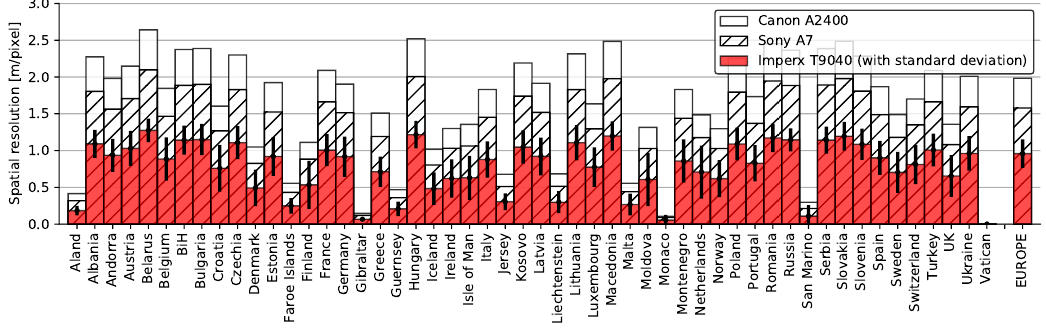
Figure 16. Spatial resolution expressed as GSD for individual countries/territories with the three